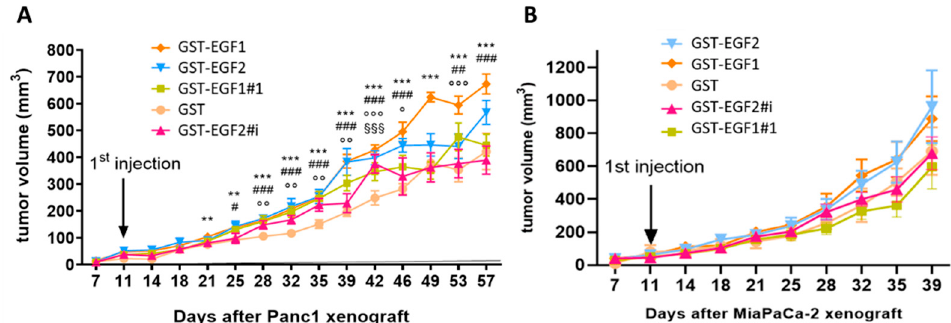
Figure 5. Impact of wild ‐ type or mutated forms of MUC4 EGF1 and MUC4 EGF2 domains on human pancreatic tumor growth in vivo. Panc ‐ 1 ( A ) or MiaPaCa ‐ 2 ( B ) cells were injected with Matrigel ® subcutaneously into flank of male Severe Combined Immunodeficient (SCID) mice ( n = 6) aged 6 weeks (CB17, Charles Rivers, France). Injections (volume 100 μ L) were performed twice a week with 2 mg/kg of GST, GST ‐ MUC4 EGF1 , and GST ‐ MUC4 EGF2 domains (wild ‐ type) or the mutated forms GST ‐ EGF1#1 and GST ‐ EGF2#i. Tumor development was evaluated twice a week by measuring the tumor volume to enlighten the tumorigenicity of each domain. * Statistically significant difference between GST ‐ MUC4 EGF1 and GST; # statistically significant difference between GST ‐ MUC4 EGF2 and GST; ¤ statistically significant difference between GST ‐ EGF1#1 and GST; § statistically significant difference between GST ‐ EGF2#i and GST; #,o p < 0.05, ** ,##,oo p < 0.01, and *** ,###,ooo,§§§ p < 0.001.